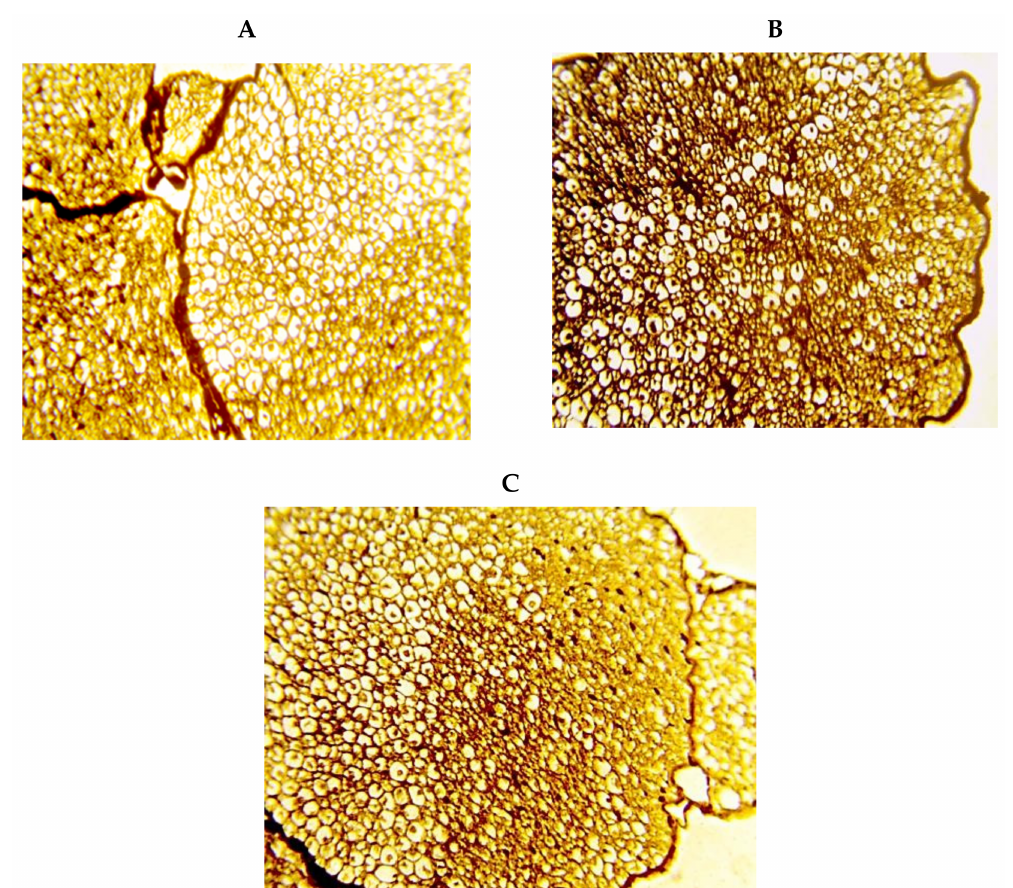
Figure 6. Silver staining for transverse sciatic nerve specimens. Images show well organized nerve fiber axons, including well-structured myelin sheathes enclosed by endoneurium in the saline group ( A ), profound staining by silver stain and a substantial decrease in the myelin sheathes in the diabetic group ( B ), less degeneration in the myelin sheathes and reduced silver staining in the DM+memantine group ( C ). Silver stain ×